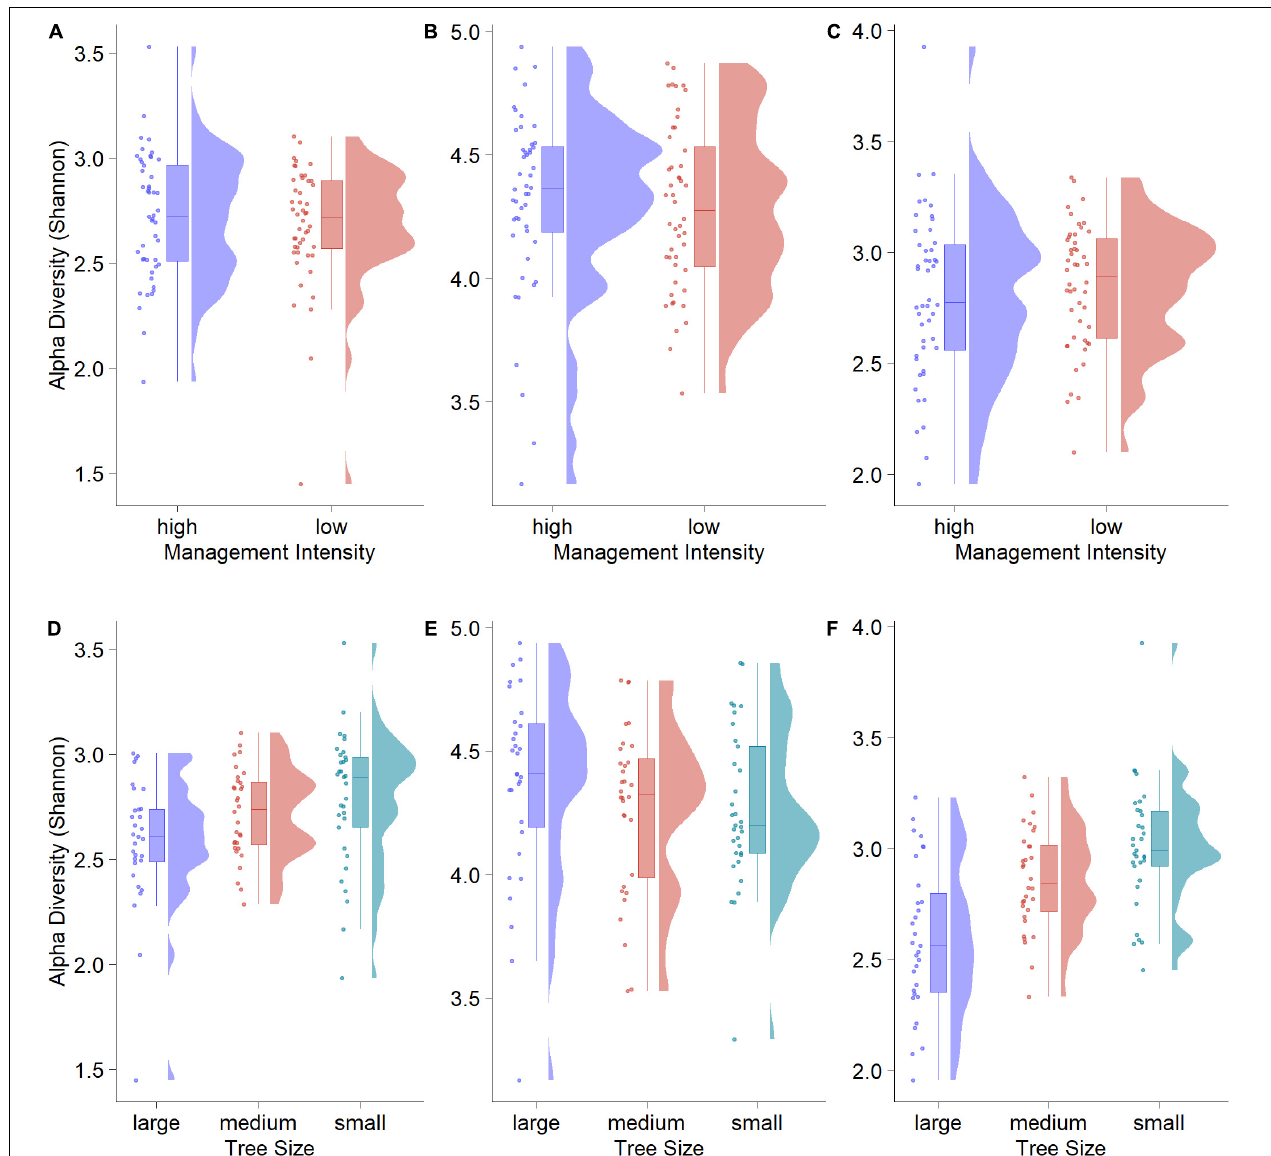
FIGURE 1 | Rain-Cloud plots of alpha diversity (Shannon) against management regime and tree size for algae (A,D) , bacteria (B,E) and fungi (C,F) . Differences are visible from the boxplots, while the original data structure is visible from raw data scatters (randomly jittered) and raw data distribution.